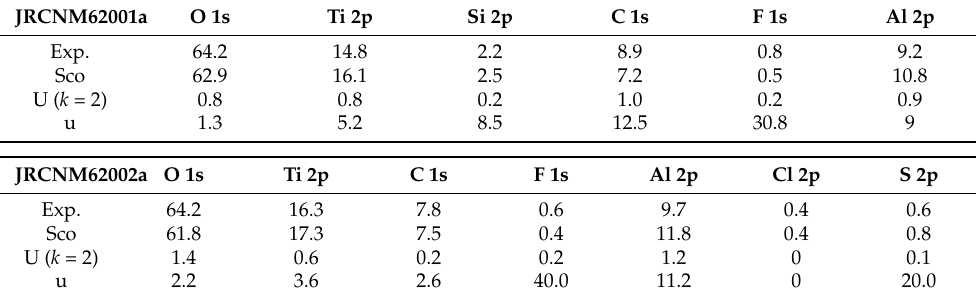
Table 5. XPS quantification results derived from experimentally and theoretically derived sensitivity factors. Exp.: experimentally derived sensitivity factors, Sco: theoretically (Scofield) derived sen- sitivity factors, U ( k = 2). Absolutely uncertainty with a confidence value of 95% derived from the difference of both methods. u: relative